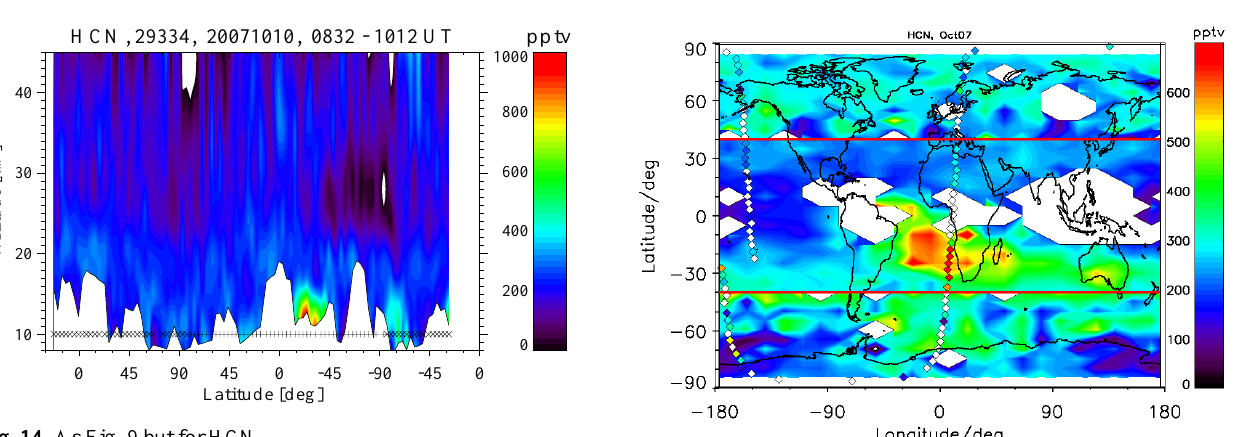
Fig. 14. As Fig. 9 but for HCN.